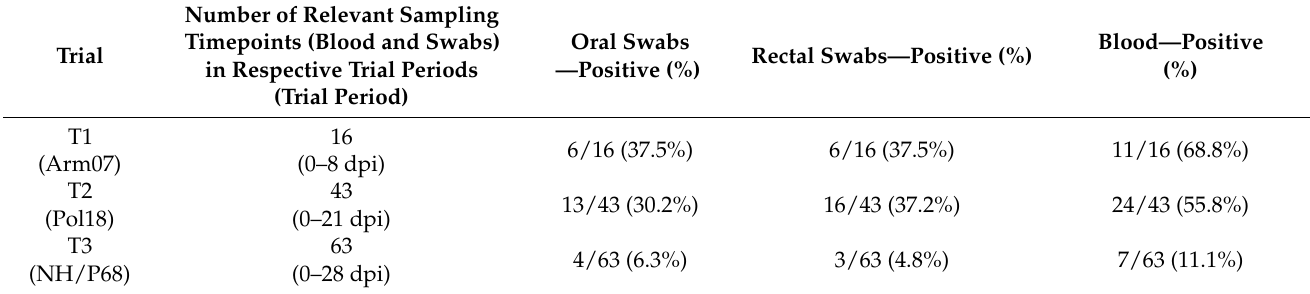
Table 4. Percentage of PCR-positive samples collected during experiments in whole trial periods.